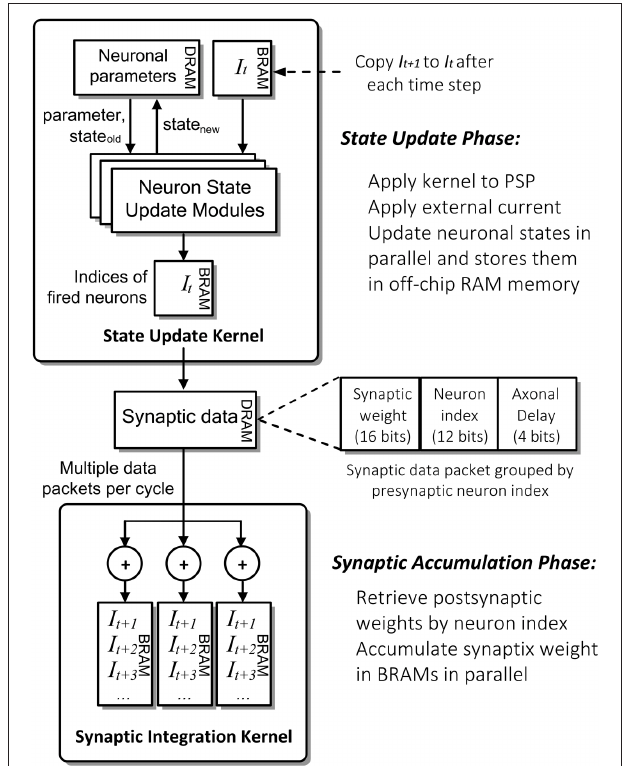
FIGURE 4 | Simplified computation flow and architecture of NeuroFlow. The system consists of two major kernels corresponding to the two main computation phases: Neuron State Kernel, which corresponds to Neuron Update Phase and calculates the updated neuronal states using the synaptic and neuronal models at each time step; and Synaptic Integration Kernel, which propagates the neuronal spikes to own and other FPGAs in Synaptic Accumulation Phase. Neuronal and synaptic parameters are stored in high-capacity off-chip memory while the others are stored in high-speed on-chip memory to optimize the overall memory